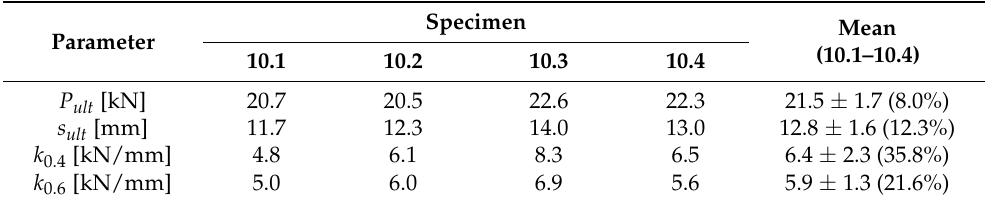
Table 9. The results of the push-out tests of the shear connections with 10 mm screws and with